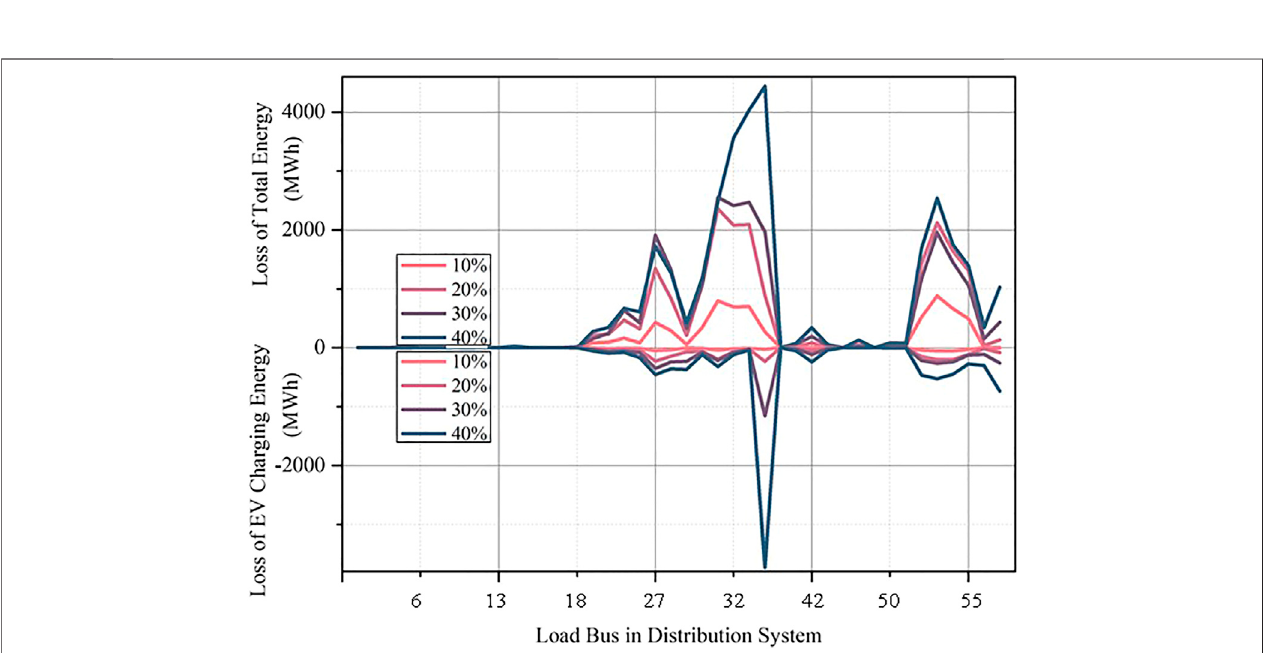
FIGURE 9 | Loss of total energy and EV charging energy at each load bus in a year based on different EV penetration.